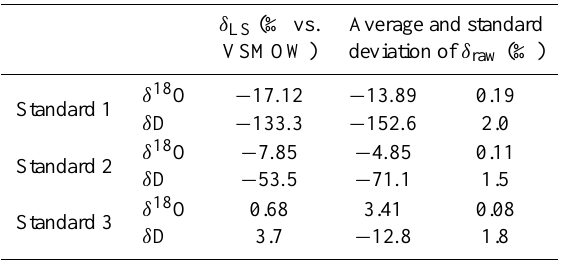
Table 1. Isotopic compositions of laboratory standards ( δ LS ), and statistics on raw measurements from all calibrations (average and standard deviation of δ raw from 40 data between 20 July to 24 Au- gust